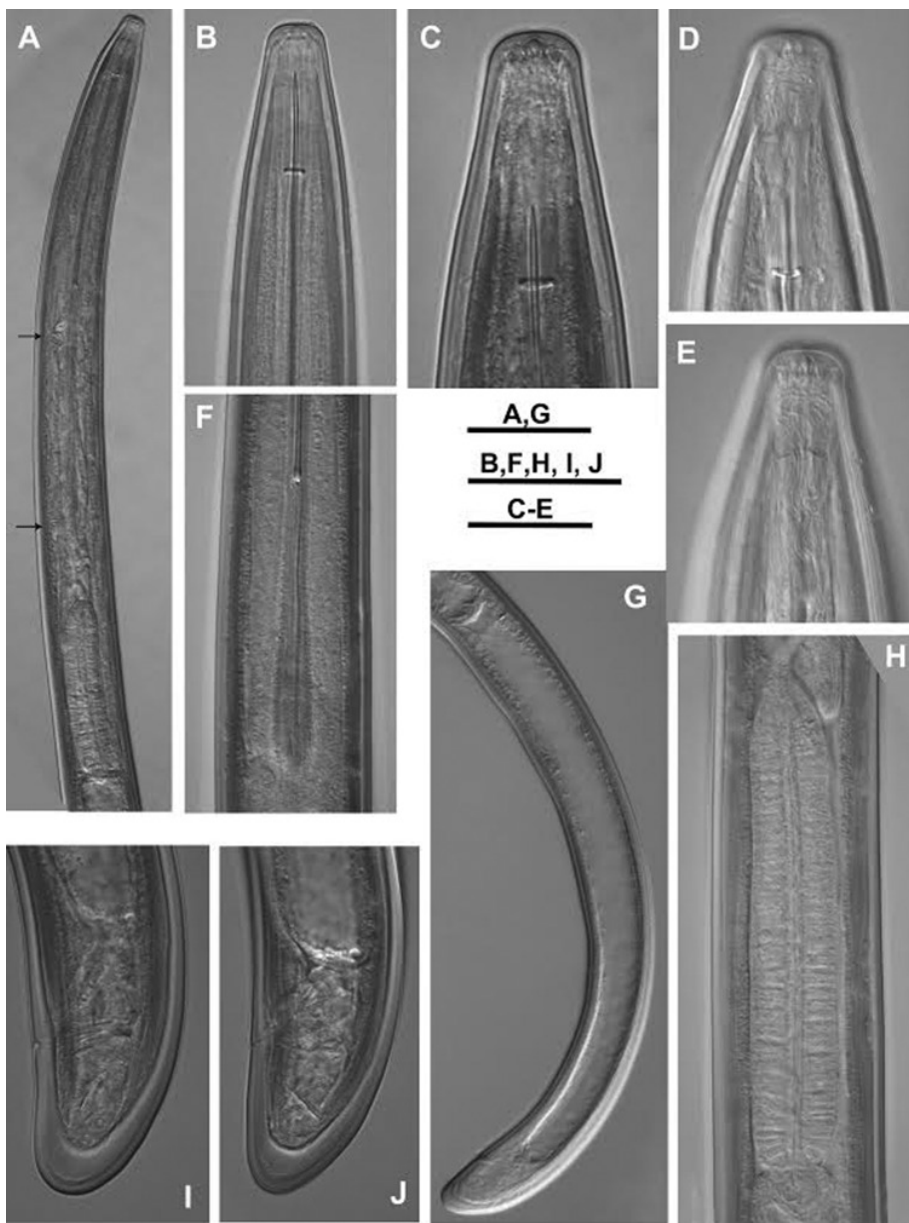
Figure 3. Longidorus piceicola Female from Bran locality: A Neck region, black arrows indicate nerve rings B, C Head end (different magnifications) D, E Amphideal fovea (right and left) F Odontophore G Prerectum H Pharyngeal bulb I, J Variations in tail shape. Scale bars: A, G 80 μm; B, F, H, I, J 40 μm; C–E 20